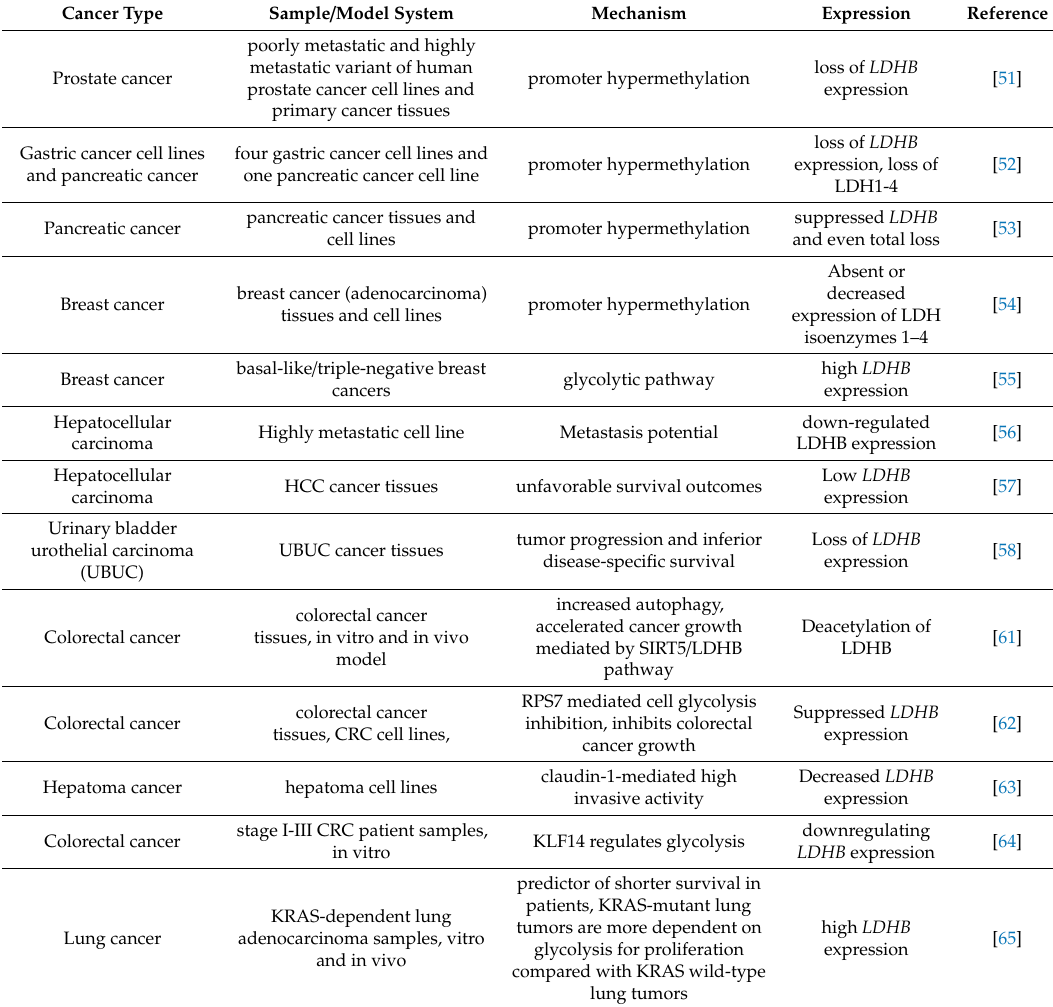
Table 2. LDHB -mediated cancer